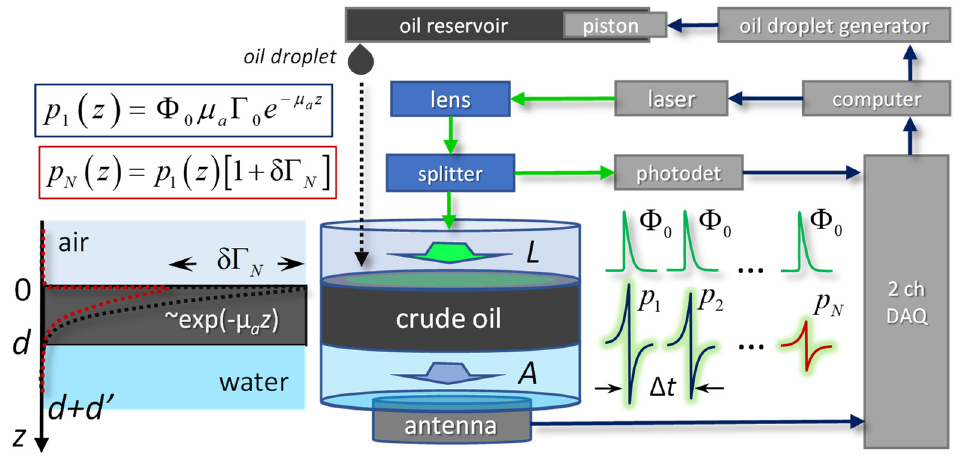
Figure 1. Optoacoustic characterization of oil.